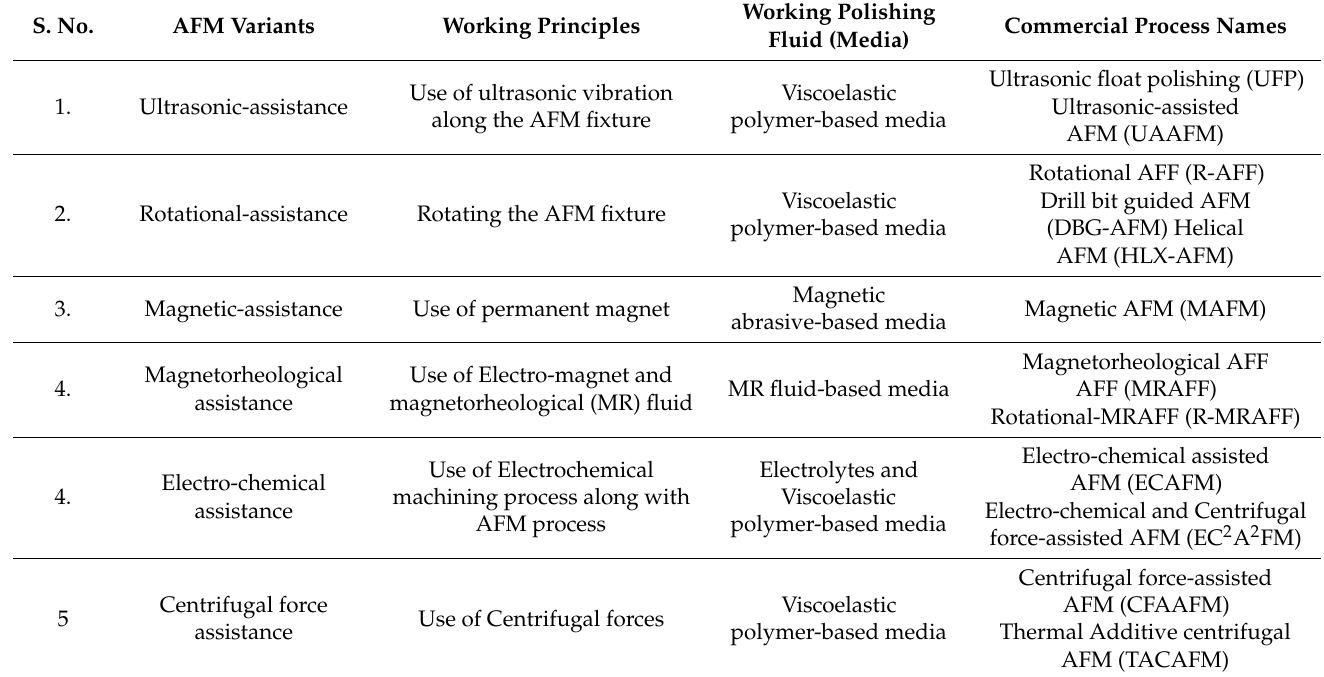
Table 2. A summary of the differences and similarities of the different AFM process